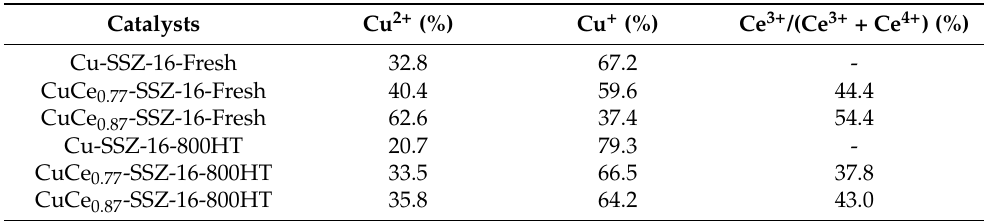
Figure 8. XPS spectra of Cu 2p ( a ) and Ce 3d ( b ) for Cu-SSZ-16-Fresh, CuCe 0.77 -SSZ-16-Fresh, and CuCe 0.87 -SSZ-16-Fresh. Table 3. The distribution of Cu and Ce species revealed by Table 3. The distribution of Cu and Ce species revealed by XPS.